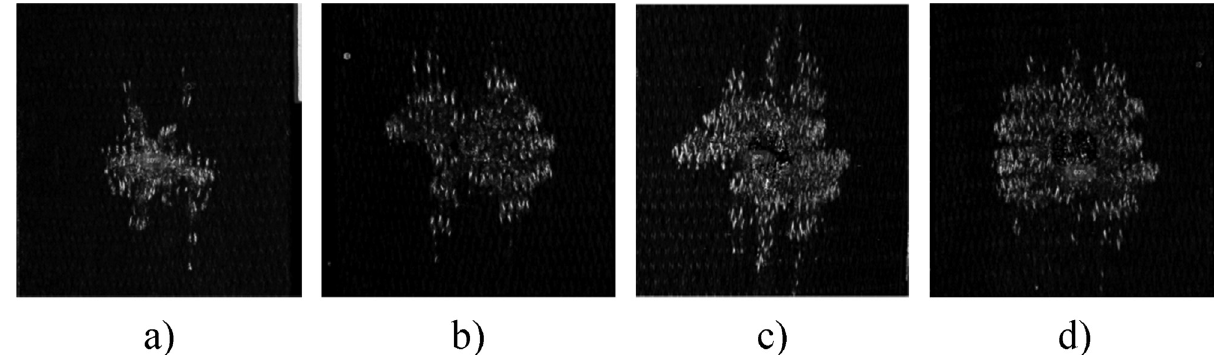
Figure 7: Internal damage of 15° braided angle specimens after impact of spherical punch: ( a ) 1 impact, ( b ) 5 impacts, ( c ) 20 impacts, and ( d ) 28 impacts.